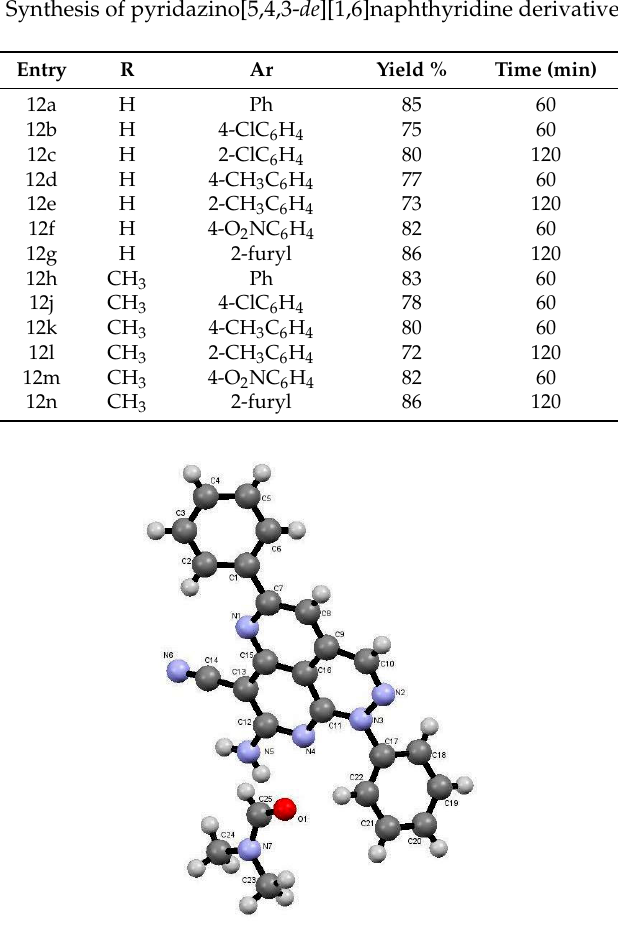
Figure 1. X-ray crystallographic structure of compound 12a [25].